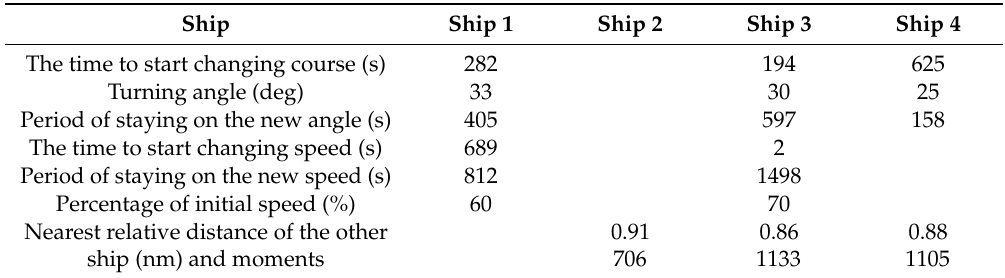
Table 2. Actions taken by each ship in scenario